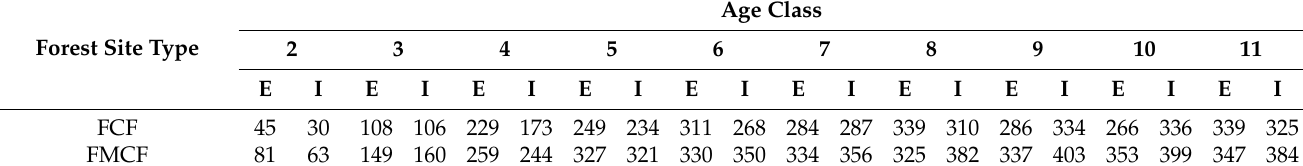
Forest Site Type